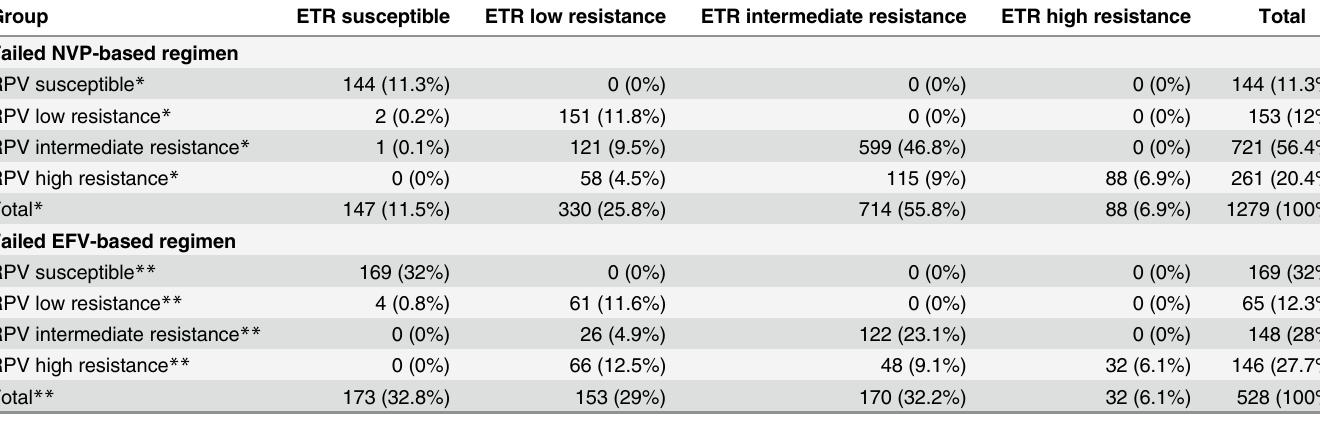
Table 2. Number of patients susceptible to etravirine and